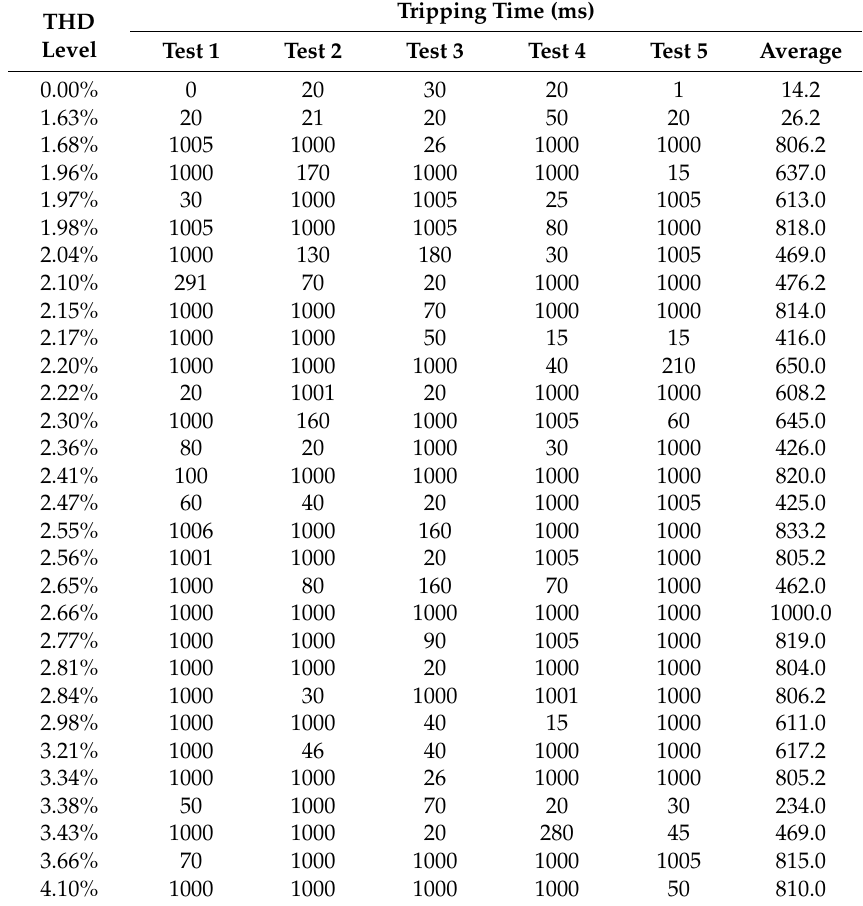
Table 4. Data from distance relay’s tests with fault near to the border from zone 1 to zone 2. THD Level